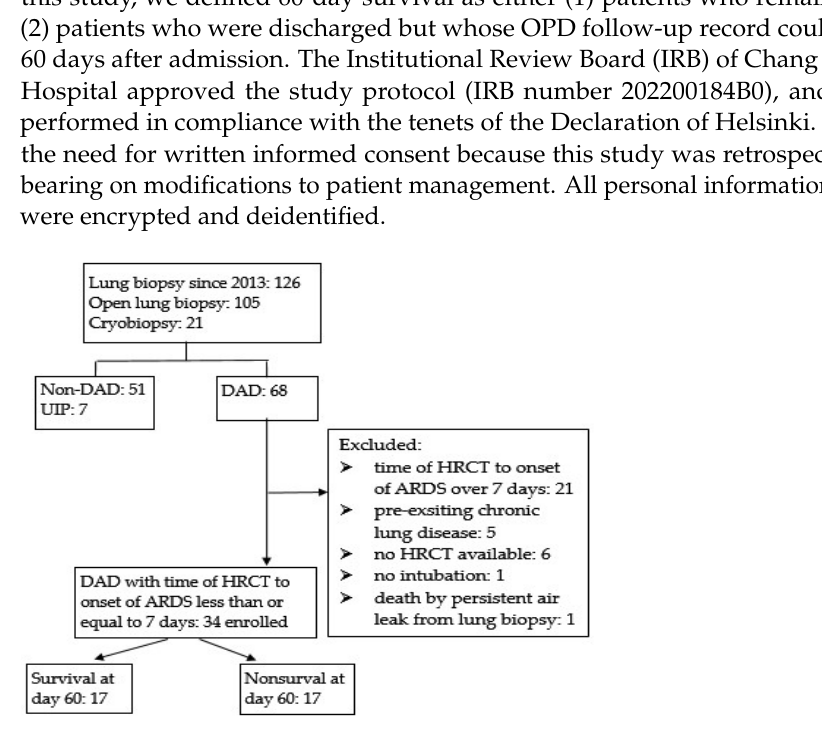
Figure 1. Flow chart for patient enrollment. DAD: diffuse alveolar damage; UIP: usual interstitial pneumonia.